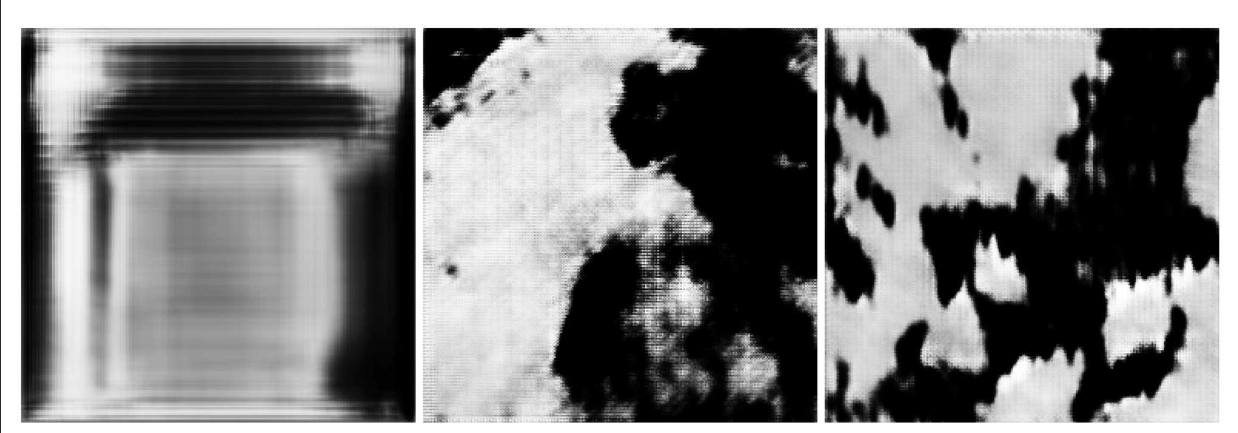
FIGURE7 R_DCGAN (Radford et al., 2016) on the cloud data set (left) , T_DCGAN (2020b) with perspective correction (middle) , and T_DCGAN without perspective correction (right) .